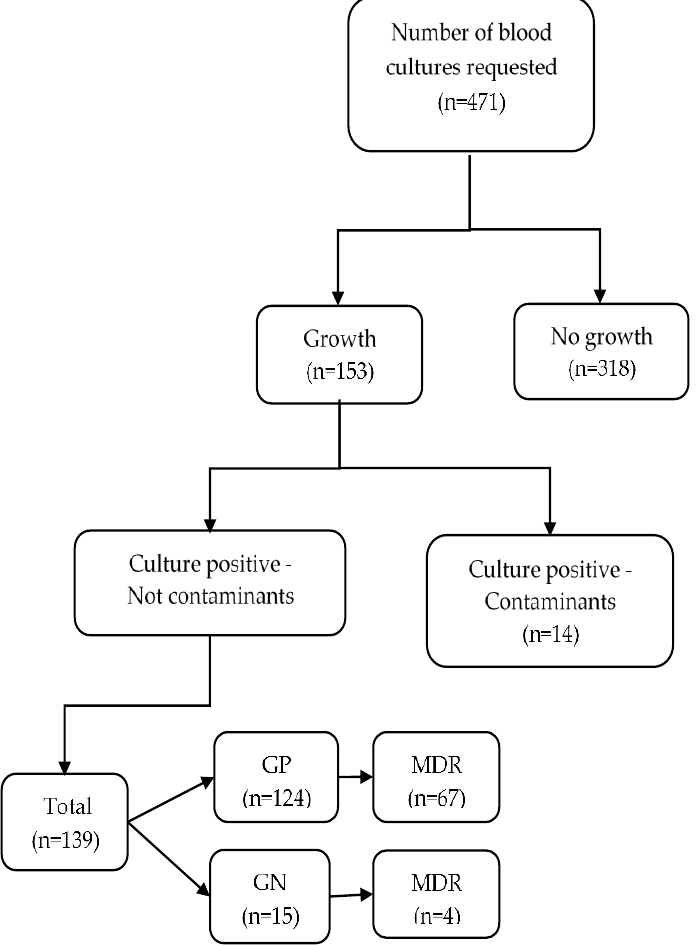
Figure 1. Culture positivity and multidrug resistance among neonates with suspected sepsis who underwent culture sensitivity testing at the 37 Military Hospital, Accra, Ghana (2017–2020). GP = Gram-positive isolate, GN = Gram-negative isolate, MDR = multidrug resistant (resistance to at least one antibiotic from three or more antimicrobial categories). Table 1. Baseline characteristics and exit outcomes of neonates with suspected sepsis who under- went culture and antibiotic sensitivity testing at the 37 Military Hospital, Accra, Ghana (2017–2020).